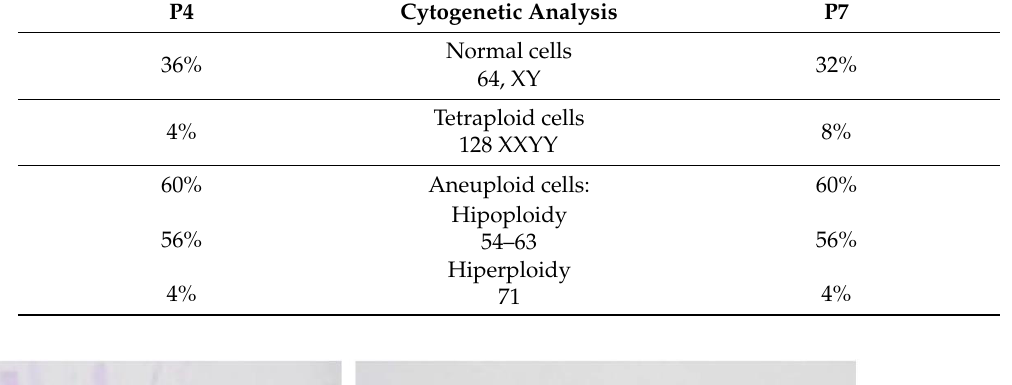
Table 6. Cytogenetic analysis in Passages 4 and 7 (P4 and P7). Percentage of normal cells, tetraploid cells, and aneuploid cells.